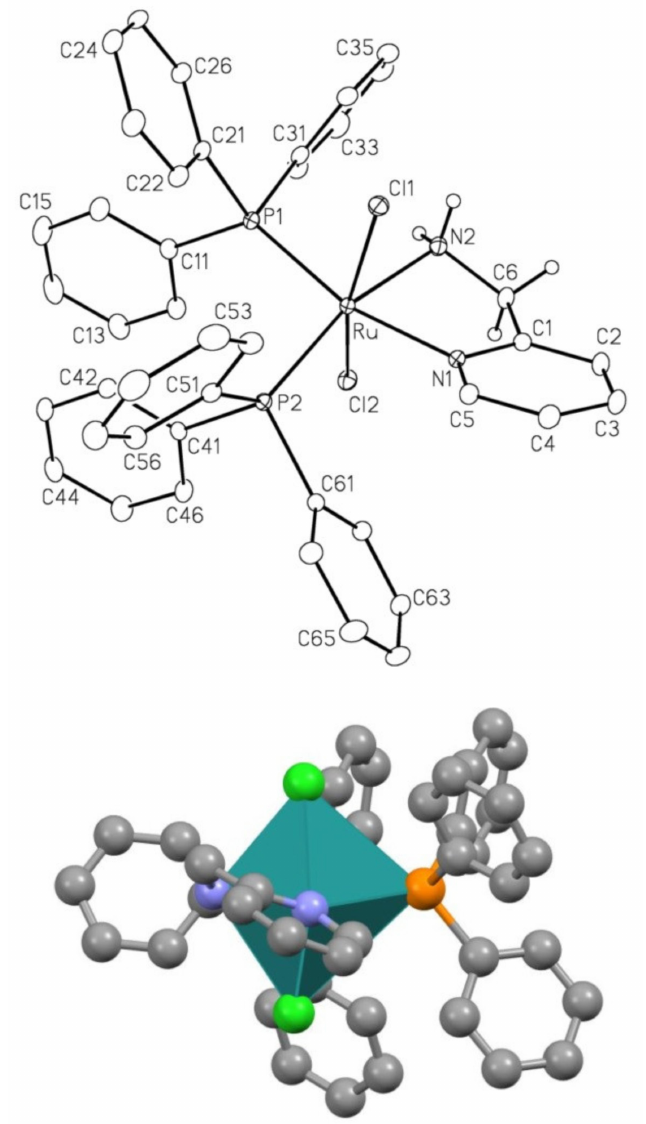
Figure 2. Crystal structure of trans -[RuCl 2 (PPh 3 ) 2 (Picam)] (1) showing 30% thermal probability and green shows the Ru(II) core